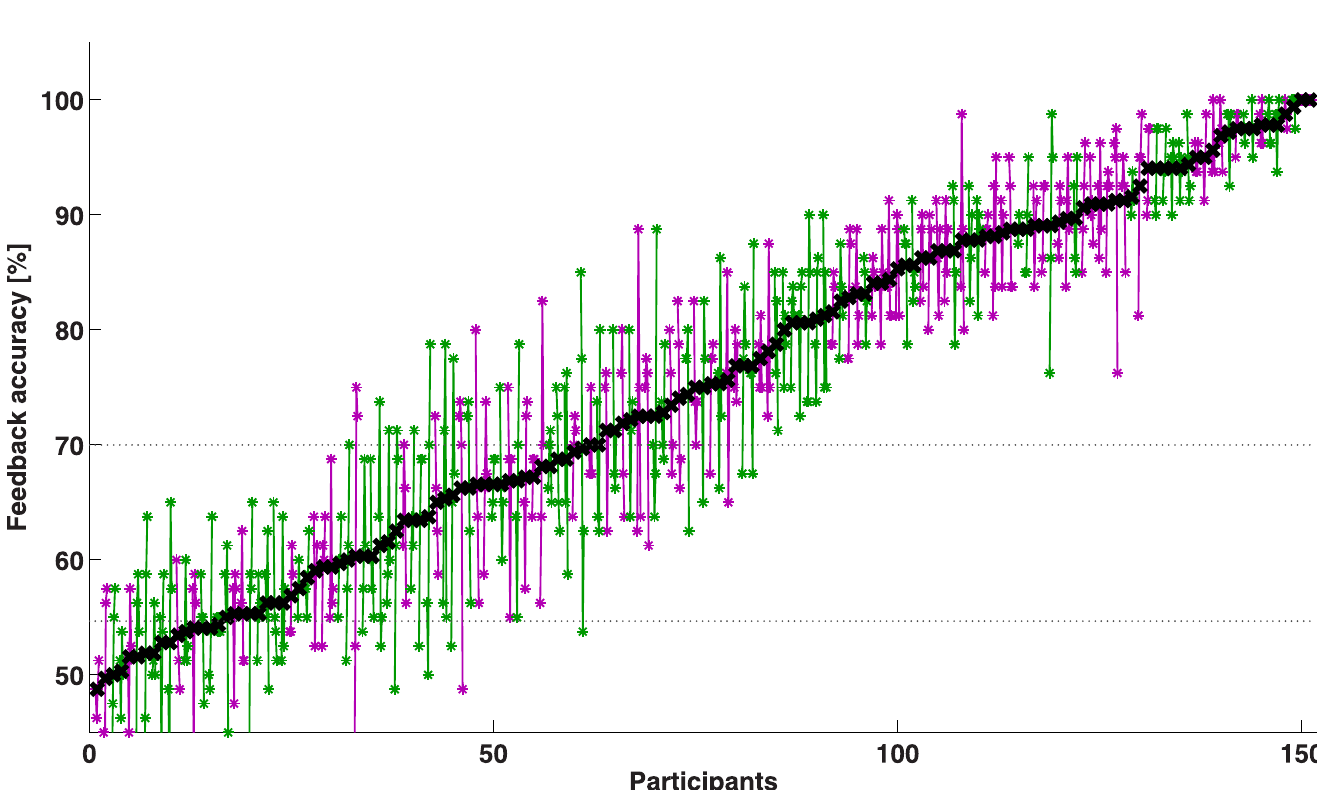
Fig 2. Overview of BCI performances sorted in ascendent order. For each participant, the black crosses indicate the overall mean feedback accuracy and the colored stars the accuracies of the four feedback runs (4 – 7). The participants of Berlin are displayed in magenta and the ones of Würzburg in green. The accuracies of each participant are connected by colored lines that emphasize the variance of the accuracies between runs. The dotted gray lines represent the accuracy considered necessary for BCI control (70%) and the threshold for accuracy significantly higher than chance (54.69%).